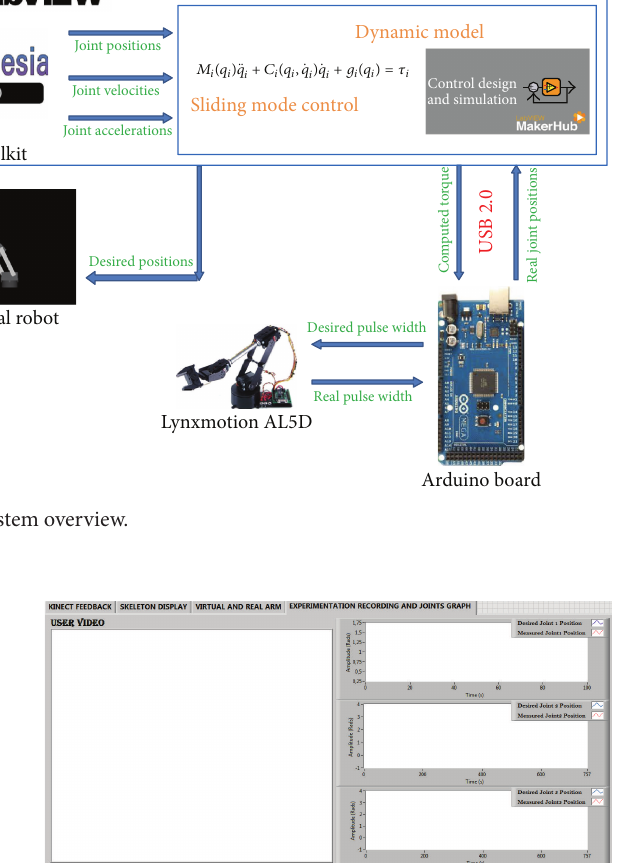
Figure 6: First screen of the user interface.